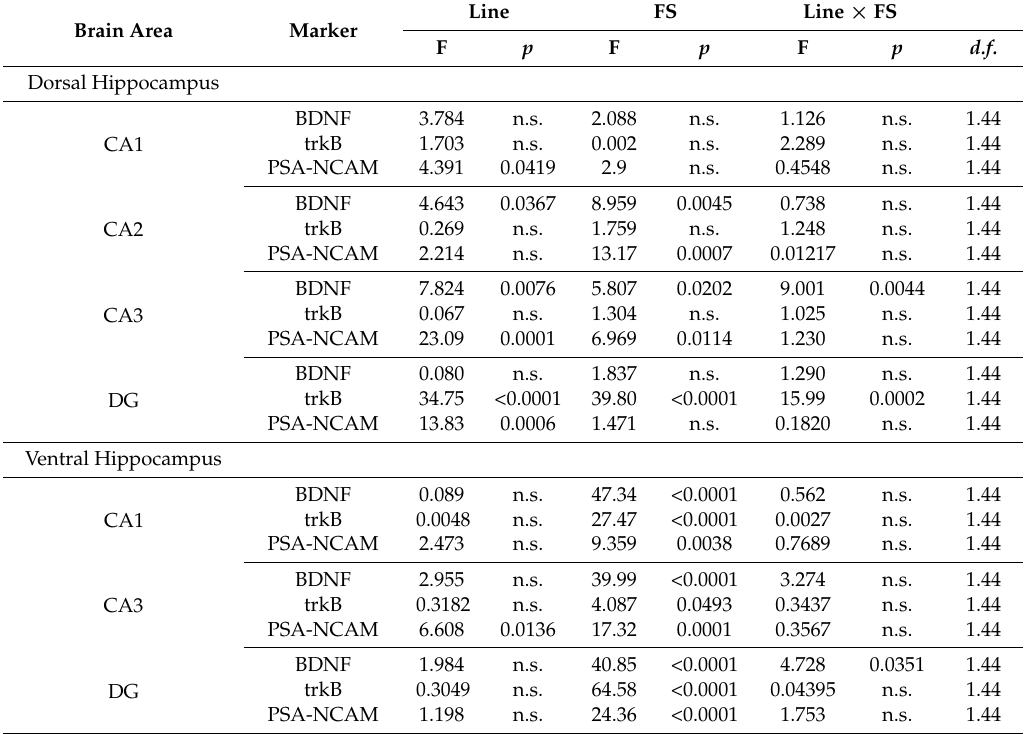
Table 2. F values and significance levels of two-way ANOVAs performed on data obtained from the densitometric analysis of tissue section distribution of the BDNF- like immunoreactivity (LI), the trkB-LI, and the PSA-NCAM-LI, shown in Figures S1–S6. Brain